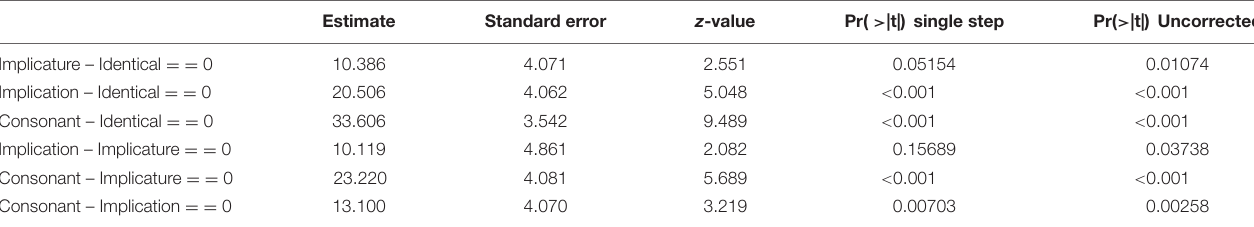
TABLE 1 | Simultaneous tests for general linear hypotheses estimated with a linear mixed effect model with condition as a fixed effect and subject and target word as random